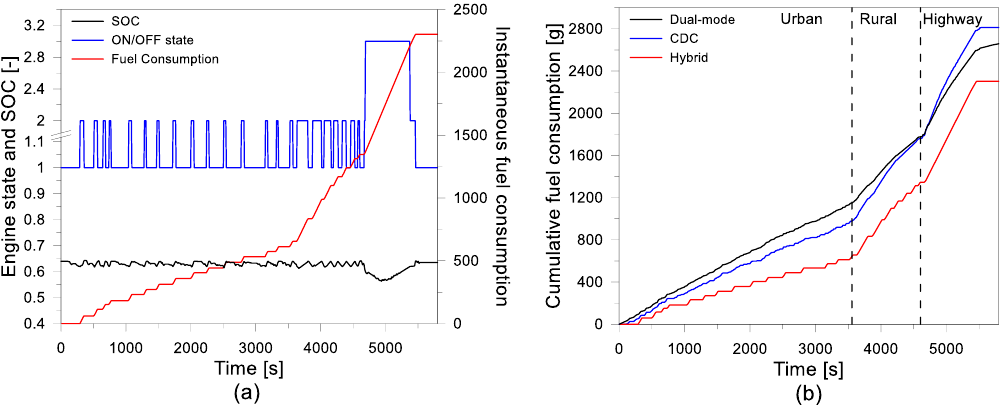
Figure 16. SOC, ICE on-off state, and cumulative fuel consumption for the hybrid powertrain ( a ) and instantaneous fuel consumption comparison for the different concepts ( b ) during the RDE cycle.